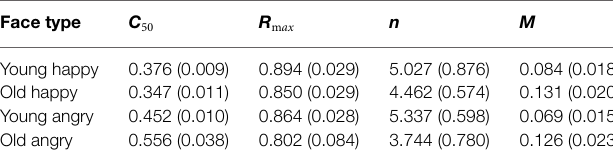
TABLE 3 | Means and standard errors of best-fit values of psychometric curve fit